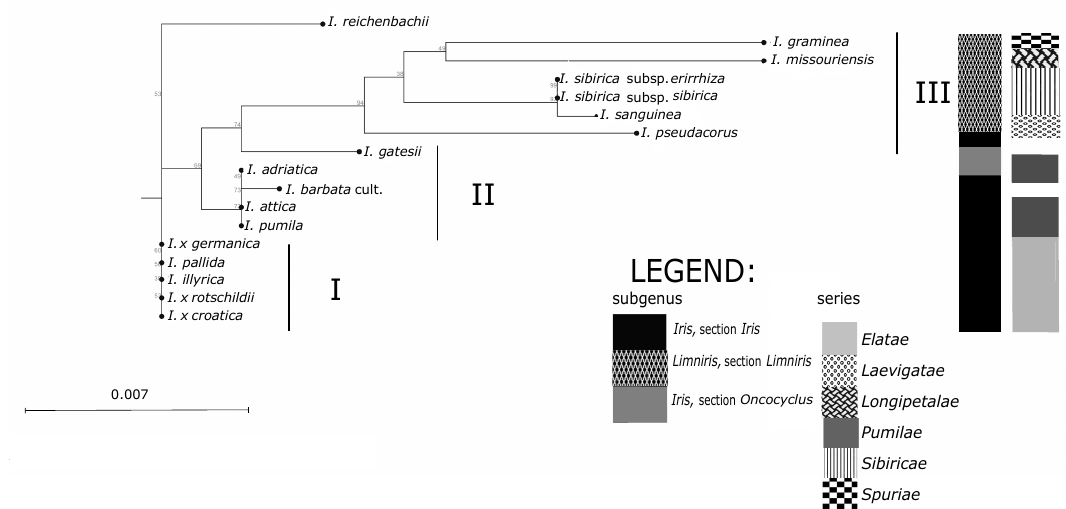
Figure 4. Maximum Likelihood (ML) tree of 32 Iris samples and sequences from NCBI (http: // www. ncbi.nlm.nih.gov) ( I. missouriensis , I. sanguinea , I. gatesii ) based on two plastid markers ( rpoC1 , ndhJ ). Bootstrap percentages are shown in the nodes of the dendrogram; labels I–III denote major clusters. 2.3. Genome Size (cid:48) 4 ,6-diamidino-2-phenylindole (DAPI) fluorochrome is known to bind to DNA,